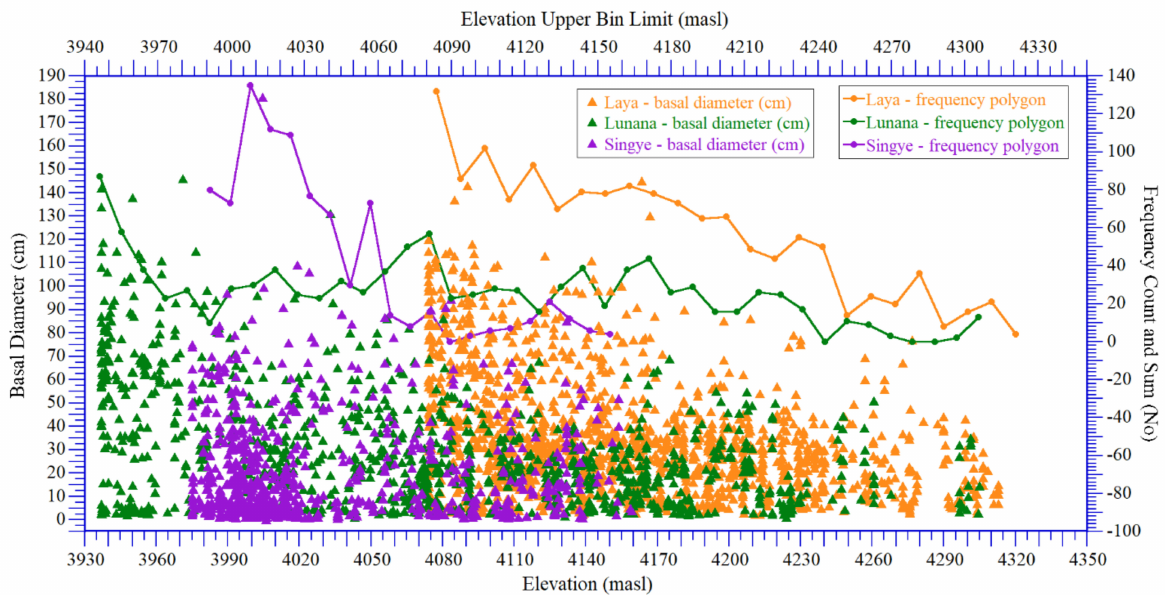
Figure 6. Tree recruitment frequency polygon and basal diameter distribution against elevation (masl). BD distributions against elevation of treeline ecotone in Lunana (green triangle), Laya (Golden triangle) and Singye (purple triangle) are shown. Tree recruitment frequency polygons against elevation in treeline ecotone of Lunana (green line), Laya (Golden line) and Singye (purple line) portray decreasing trend with